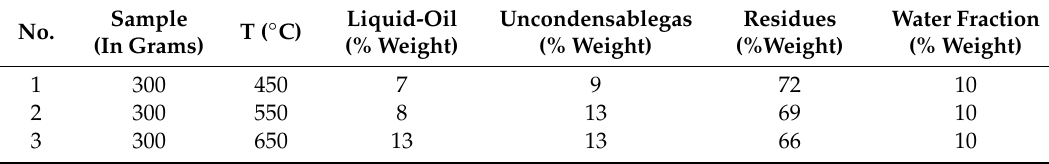
Table 1. Changes in the pyrolysis yields at di ff erent pyrolysis temperatures.